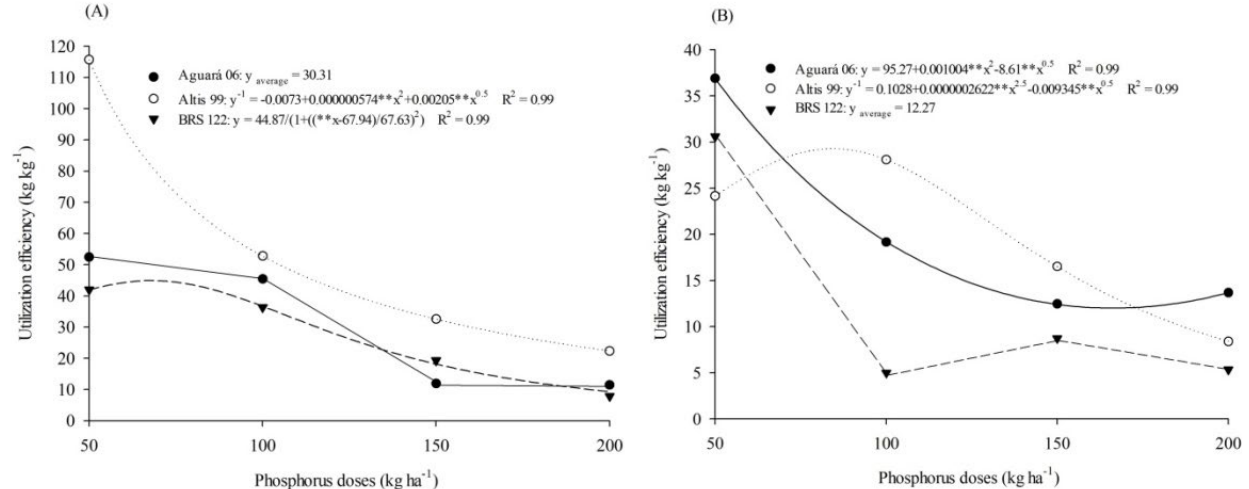
Figure 6. Utilization efficiency of sunflower as a function of phosphorus doses in the 2016 agricultural harvest ( A ) and 2017 agricultural harvest ( B ).